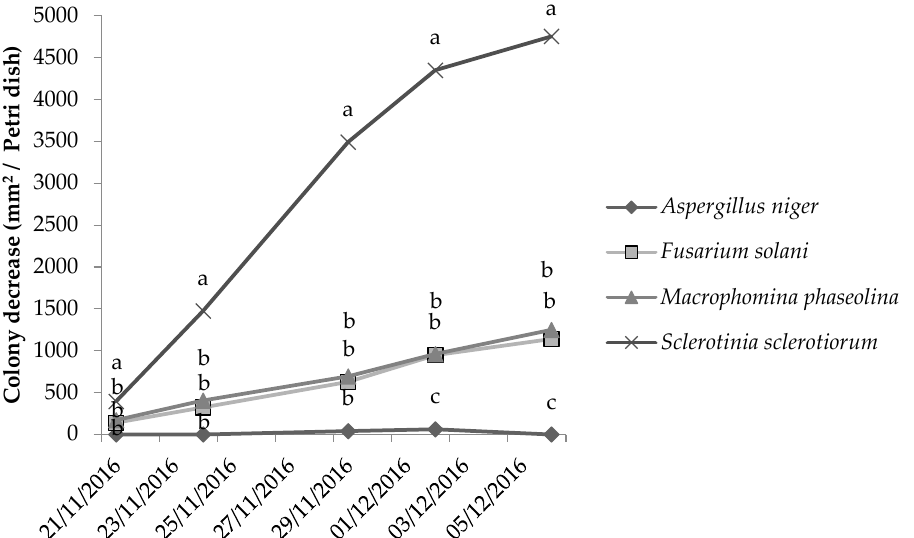
Figure 9. Number of surviving Porcellionides pruinosus individuals kept on different mycelial diets in Petri dishes. The initial number of individuals was 10 per Petri dish. Different letters for the same sampling date indicate significant differences (ANOVA, Tukey’s post hoc test). 3.2. Effect of Isopods on Fusarium Solani Infection of Stored Potato 3.2.1. Experiment A—Small Boxes The isopods left 6 of the 2’ originally healthy (not infected) tubers intact, but of the originally infected tubers, only 3 were left unharmed. Porcellio scaber individuals con- sumed significantly (10 times) more tuber material of the originally infected tubers during the experiment than individuals of P. pruinosus (Figure 10). When compared to the control, the infection rate due to F. solani was significantly lower in tubers originally infected with the pathogen. Figures for originally intact tubers, however, showed a significant differ- ence only in the case of P. scaber , as there was no significant reduction in the spread of infection on tubers in boxes with P. pruinosus (Figure 11).